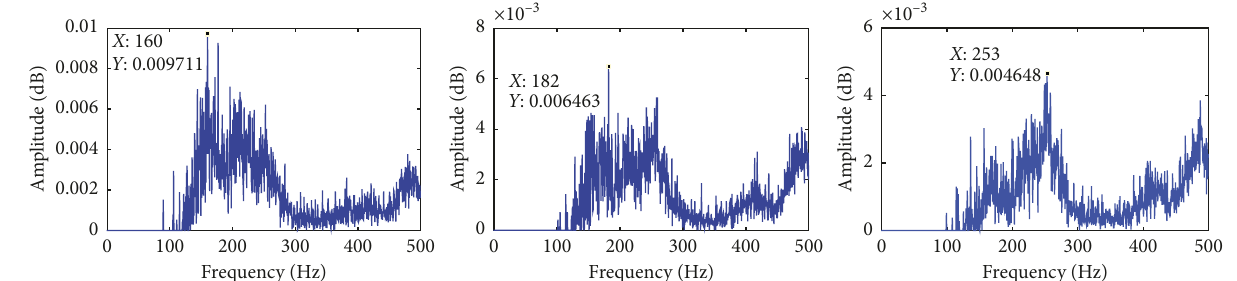
Figure 10: Hilbert marginal spectrum of three types of piezoelectric patch signals under noise signal. Table 4: Hilbert marginal spectral characteristics of three types of piezoelectric patch signals under noise signal. Hilbert marginal spectrum characteristics of the first five IMF